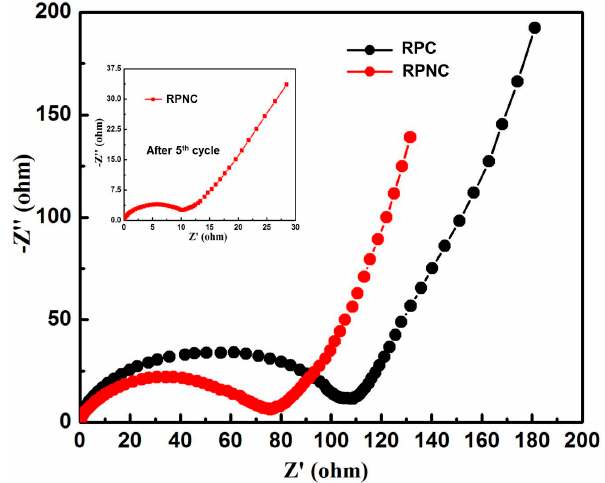
Figure 7. EIS analysis of the RPNC and rep phosphorus/carbon (RPC) composites after the initial charge/discharge cycle. The inset image is the EIS of RPNC after five cycles.